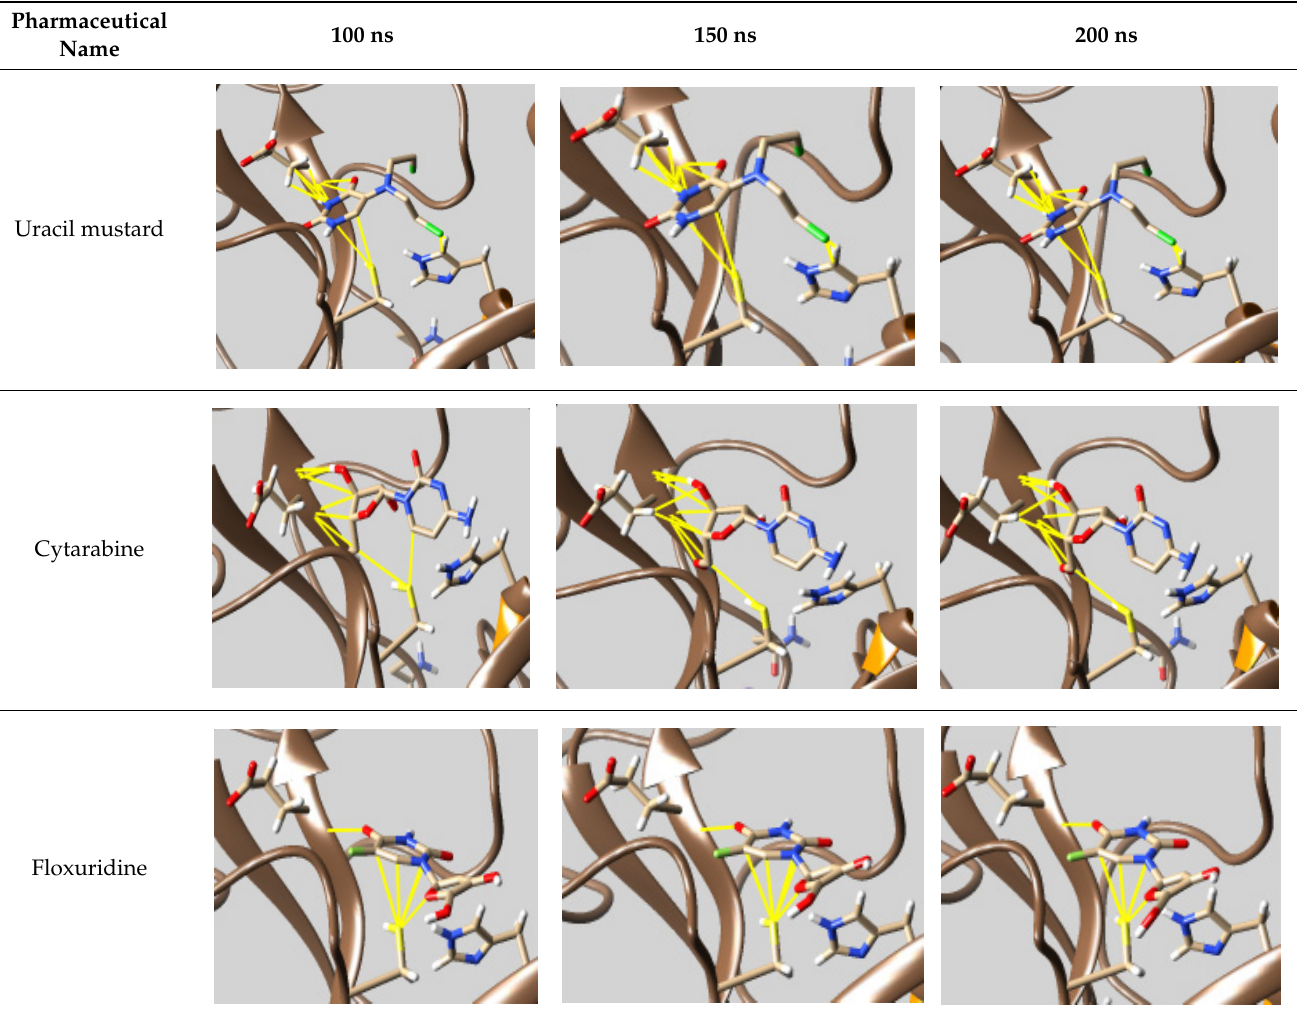
Table 3. The binding interactions of the potential pyrimidonic pharmaceuticals/3-chymotrypsin-like protease 3CL pro complexes at different times throughout the production runs.